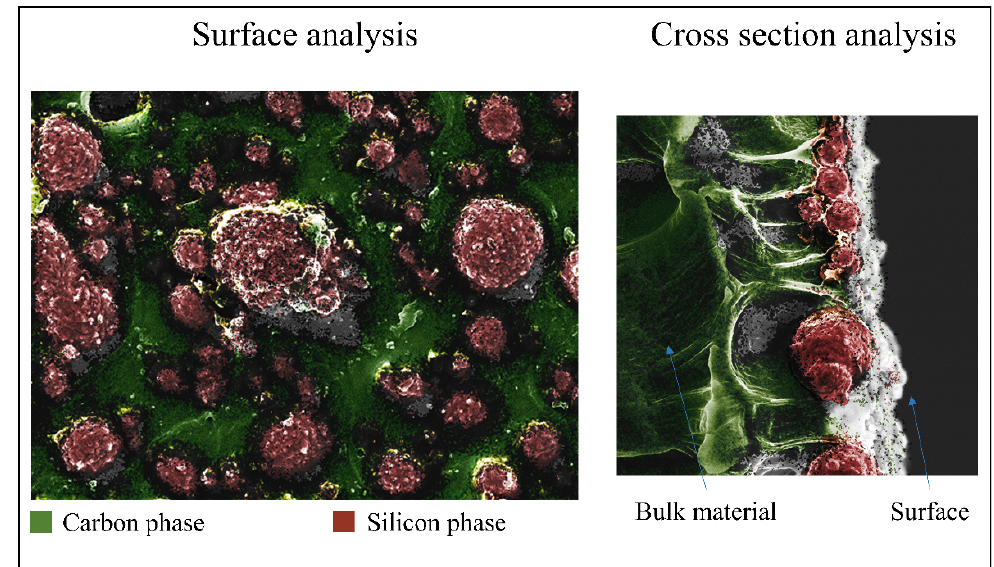
Figure 3. EDS maps of the Si 3 N 4 -coated PE substrate; surface analysis and cross section analysis on the left and right side, respectively.